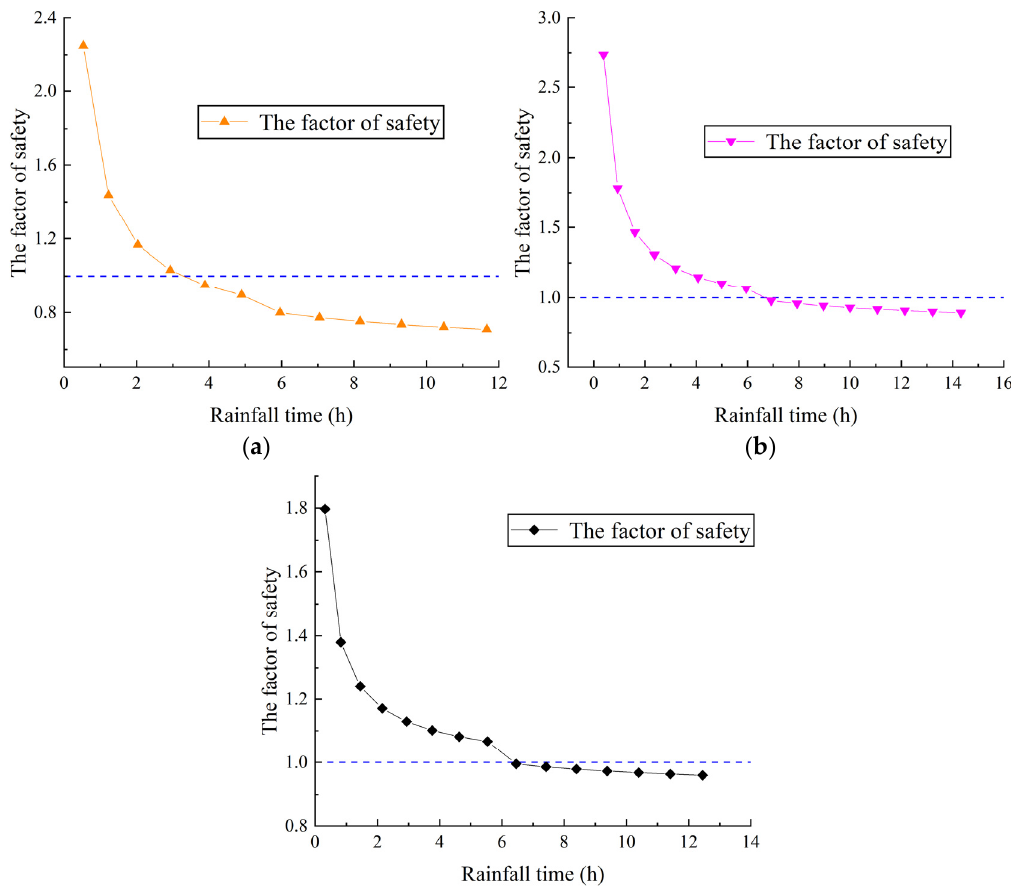
Figure 11. The relationships between rainfall time and safety factor: ( a ) Slope 1; ( b ) Slope 2; ( c ) Slope 3. Table 3. The safety factor of three slopes above.